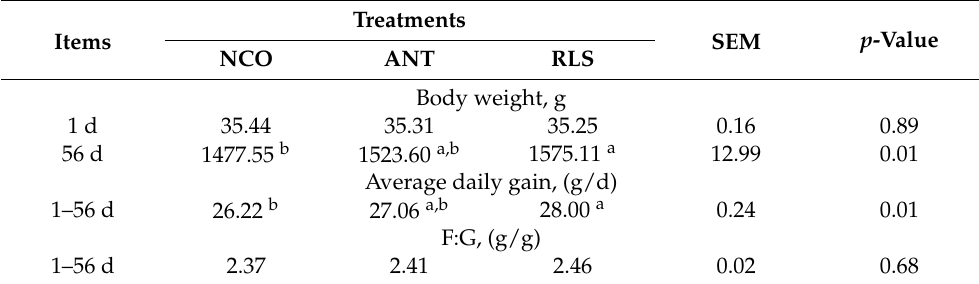
Table 1. Effects of RLS on growth performance in